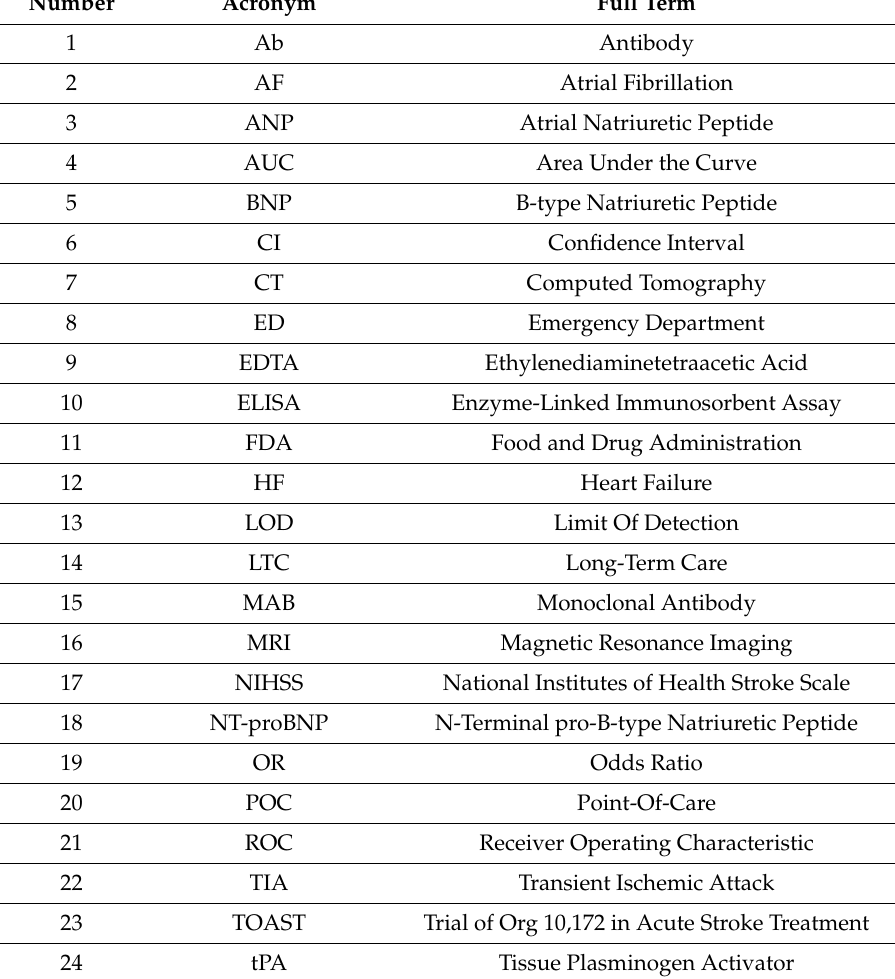
Table 3. Acronyms